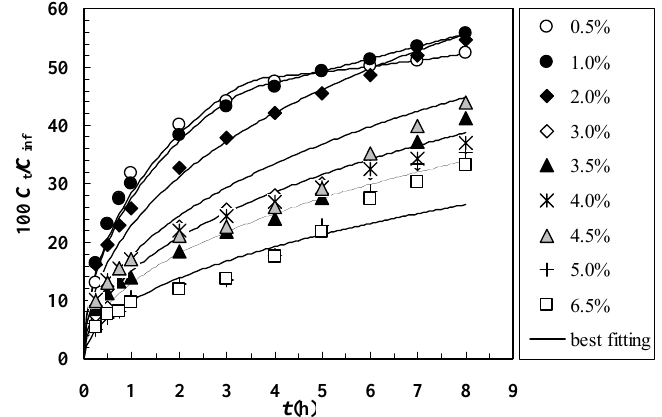
Figure 3. Comparison between model best fitting (solid line) and experimental release data (symbols) referring to gels characterized by different polymer concentrations C and C indicate the drug concentration in the release environment after time t 6.5%). C t inf and after a very long time (infinite), respectively.